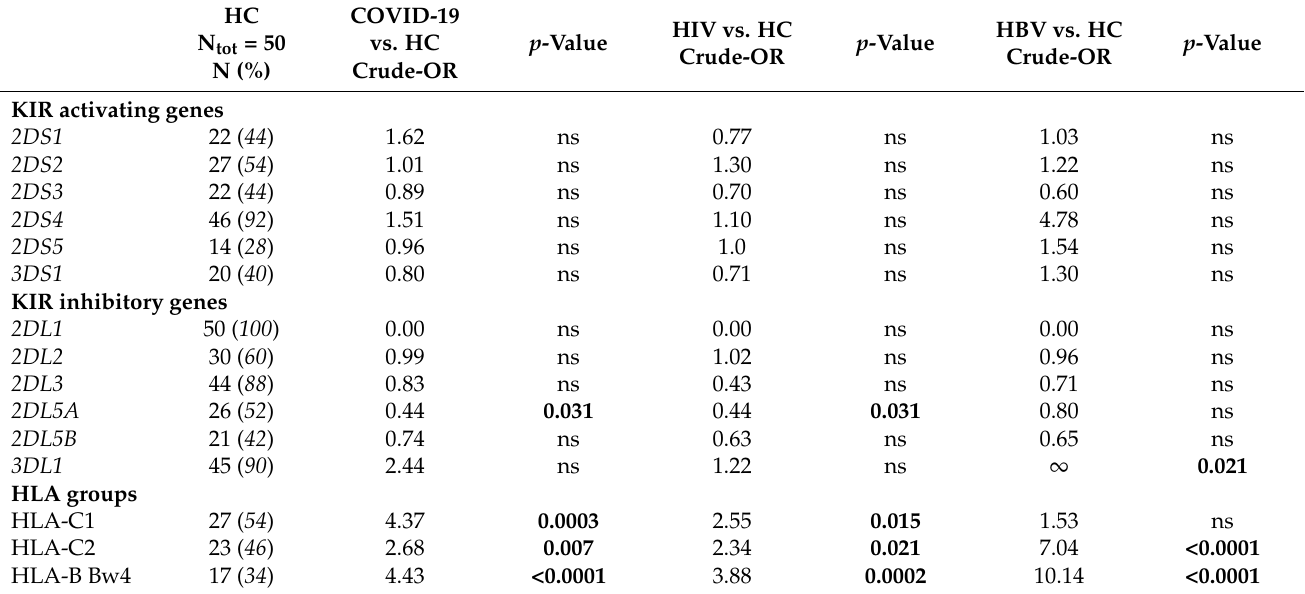
Table 2. Differences in KIR genes and HLA ligands in infected Sicilian patients and healthy controls from Sicily.